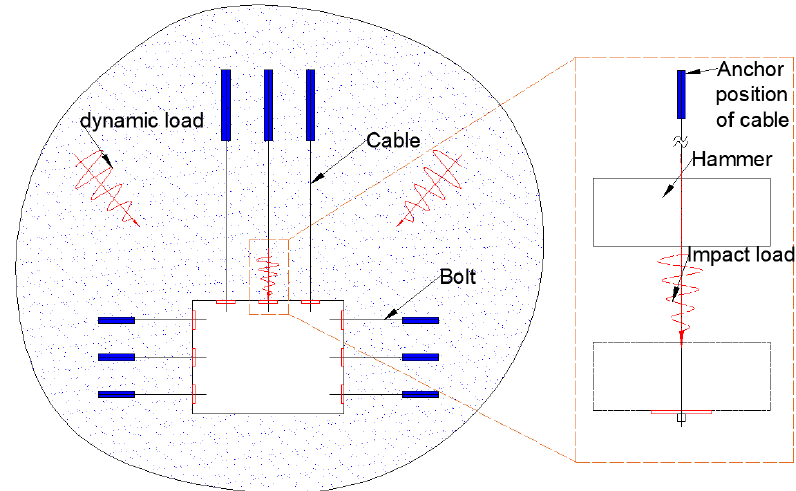
Figure 1. Dynamic load impact mechanical model of roadway support system.